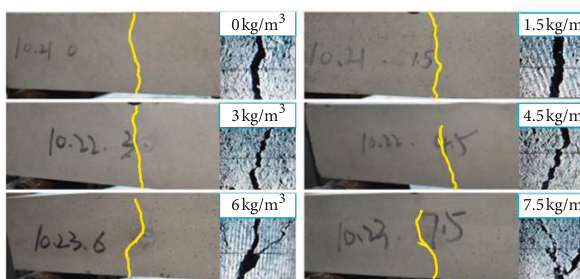
Figure 5: Failure and crack